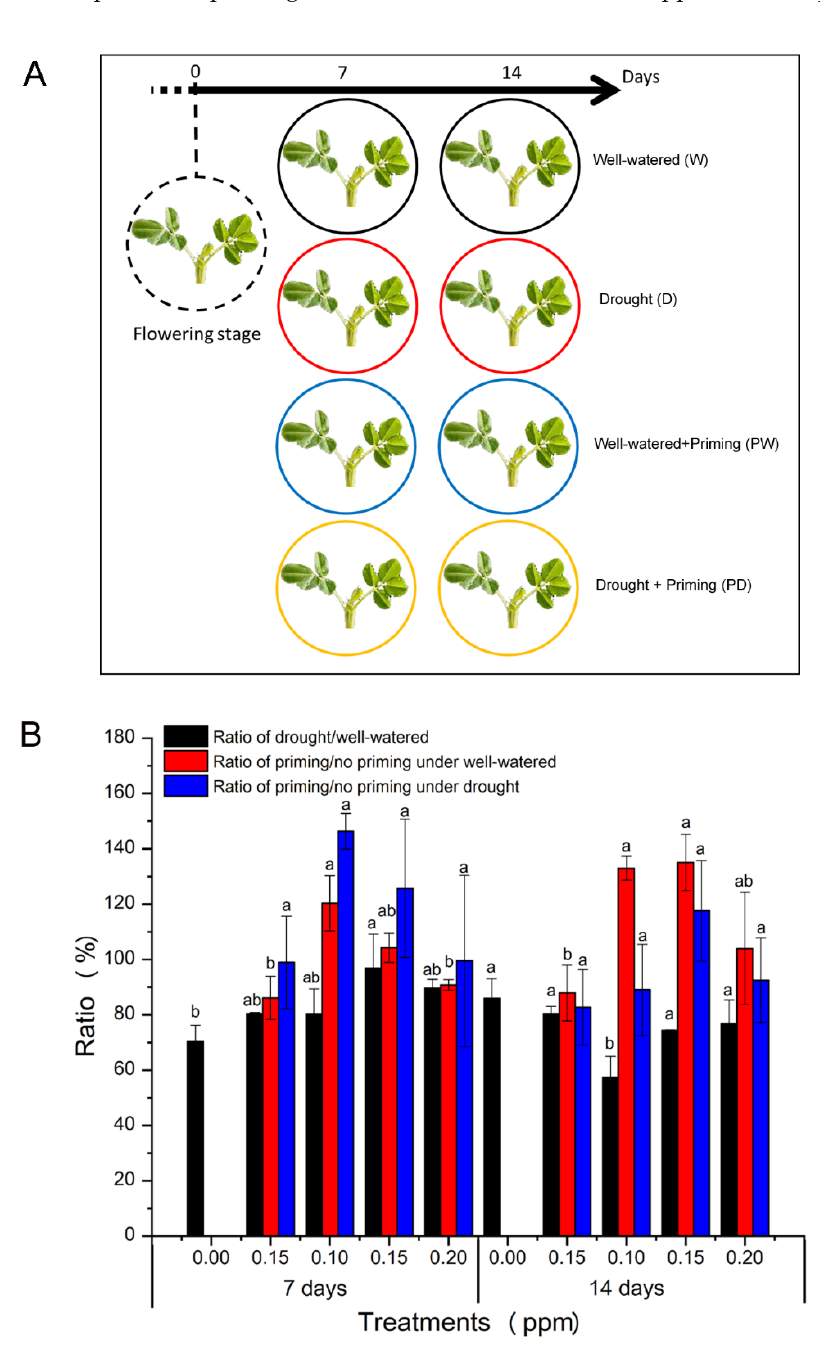
Figure 1. Effects of seed priming with brassinolide on plant height of peanut under well-watered and drought conditions. 32-day-old peanut plants were grown from seeds with or without brassinolide solutions priming at 0 ppm as the blank control, 0.05 ppm, 0.10 ppm, 0.15 ppm, 0.20 ppm. ( A ) A diagram scheme showing that the plants at in florescence stage were treated with drought or well- watered condition for 7 d or 14 days. ( B ) Relative ratio of plant height. Three experiments were conducted, each with six plants. Letters represent the statistically significant difference between ratios ( p < 0.05) as determined by the least significant difference test at 7 days and 14 days, respectively. Data represent the mean ± standard error from three replicated experiments. Comparisons of dry weight of roots (DWR), stems (DWS), and leaves (DWL) showed that drought significantly reduced ( p < 0.05) the biomass of DWR, DWS, and DWL compared with those